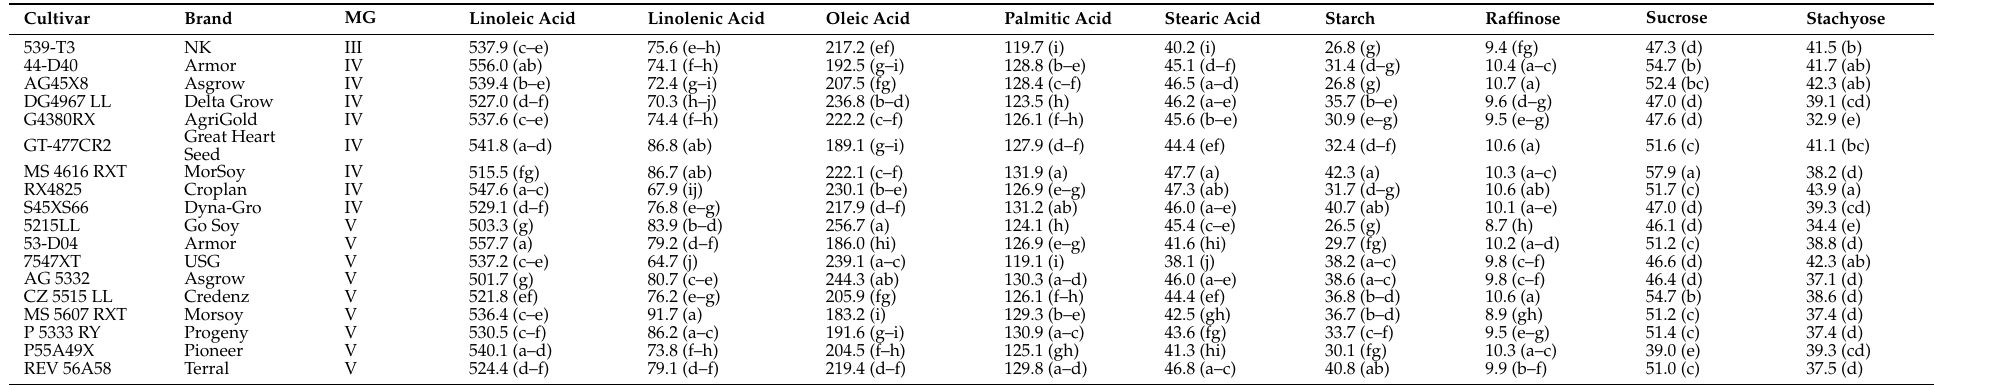
Table 2. Variations in linoleic acid, linolenic acid, oleic acid, palmitic acid, stearic acid, starch, raffinose, sucrose, and stachyose (g per kg) of 18 soybean cultivars grown under nonstress